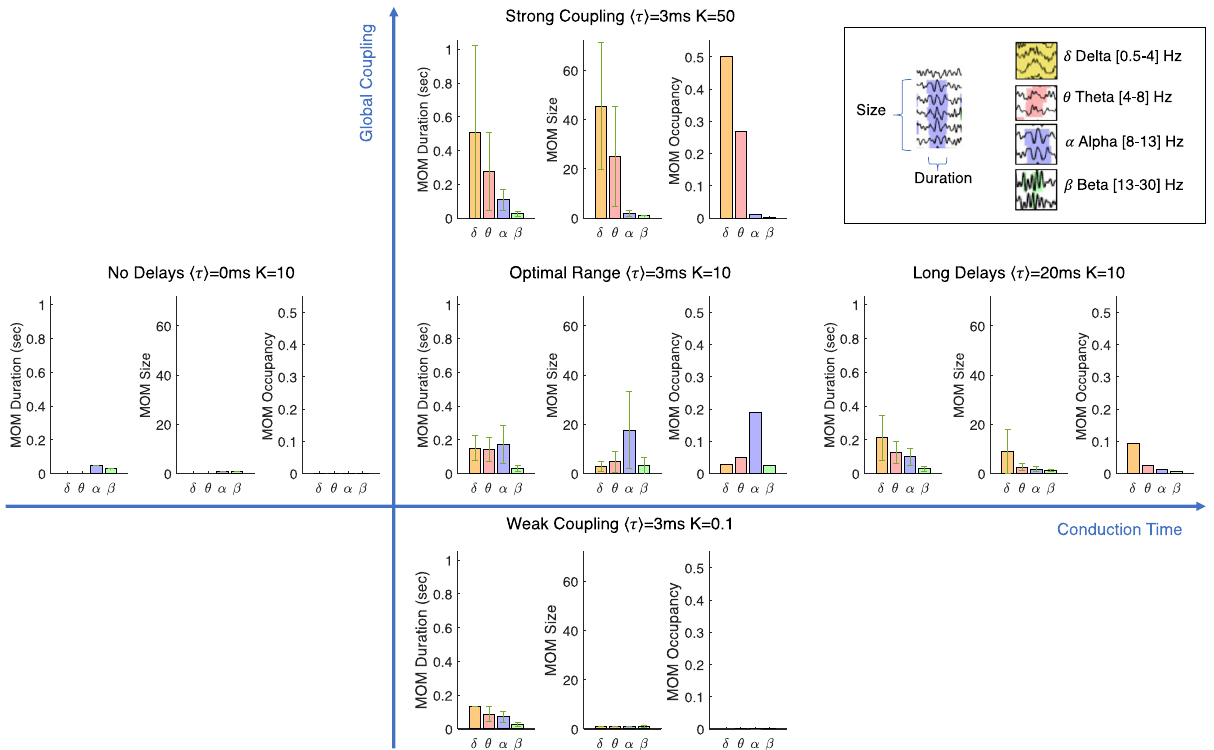
Fig. 6 Characterization of metastable oscillatory modes (MOMs) emerging from the system. For different Global Coupling strength (K) and Conduction Delays 〈 τ 〉 , MOMs are characterized in terms of duration (i.e., consecutive time that the power remains above threshold), size (i.e., the number of units simultaneous displaying power above threshold) and occupancy (i.e., the proportion of time that the power is detected above threshold over the entire simulation), for each frequency band. This demonstrates that the same network structure, i.e., the connectome, can exhibit different oscillatory modes organized in space and in time, depending on global parameters of the system. In the critical range of parameters (Optimal Range), oscillations in the alpha frequency band emerge more frequently and involve more units. Globally synchronized delta oscillations — as typically observed in states of reduced consciousness — are associated to an increase in the global coupling strength (Strong Coupling). Error bars represent 1 standard deviation. See also Supplementary Movie